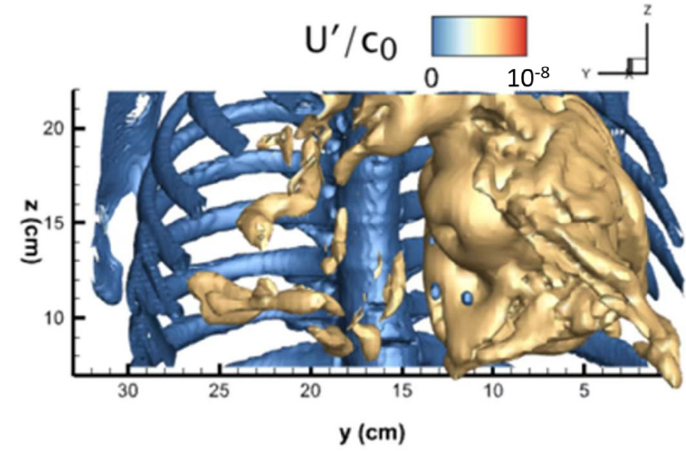
Figure 6. Isosurface of magnitude of velocity fluctuation and part of the skeletal system in the moderate MR case at 0.105 s. Smaller y values indicate the left-hand side of the body.